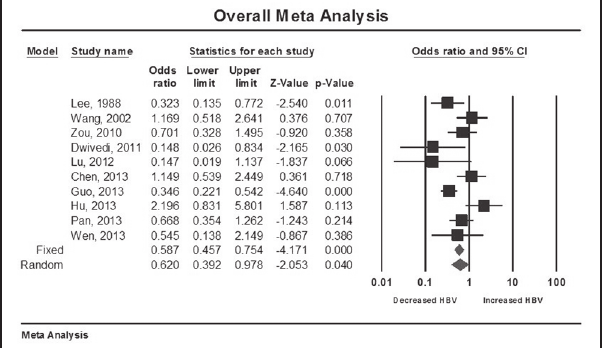
Figure 2) Meta-analysis of hepatitis B virus transmission risk with Caesarean section versus vaginal delivery